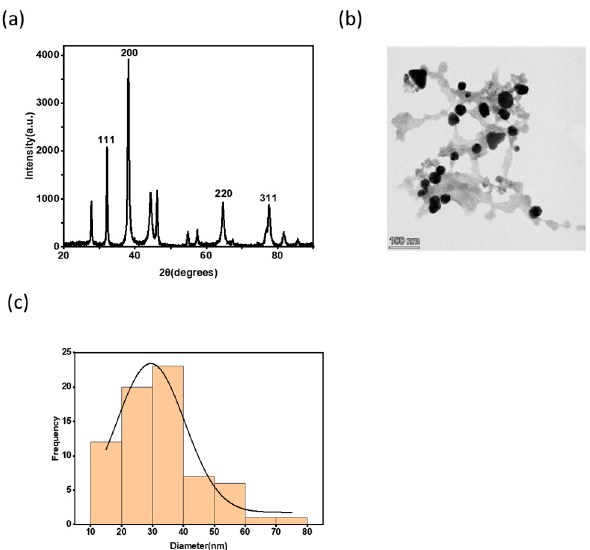
Figure 1. ( a ) XRD of the biosynthesized Au–Ag nanoparticles; ( b ) TEM image for the colloidal bio- synthesized Au–Ag NPs solution; and ( c ) the Gaussian statistic size distribution of the nanoparticles (30 nm).